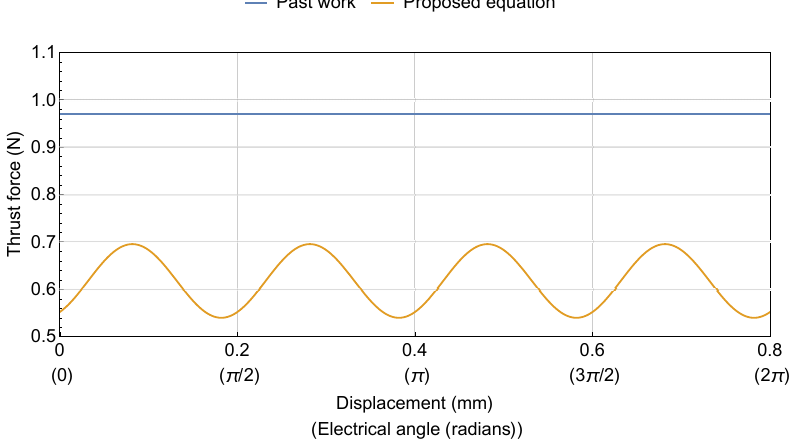
Figure 4. Comparison of the thrust force output, as a function of displacement, between the newly proposed equation and the one reported in